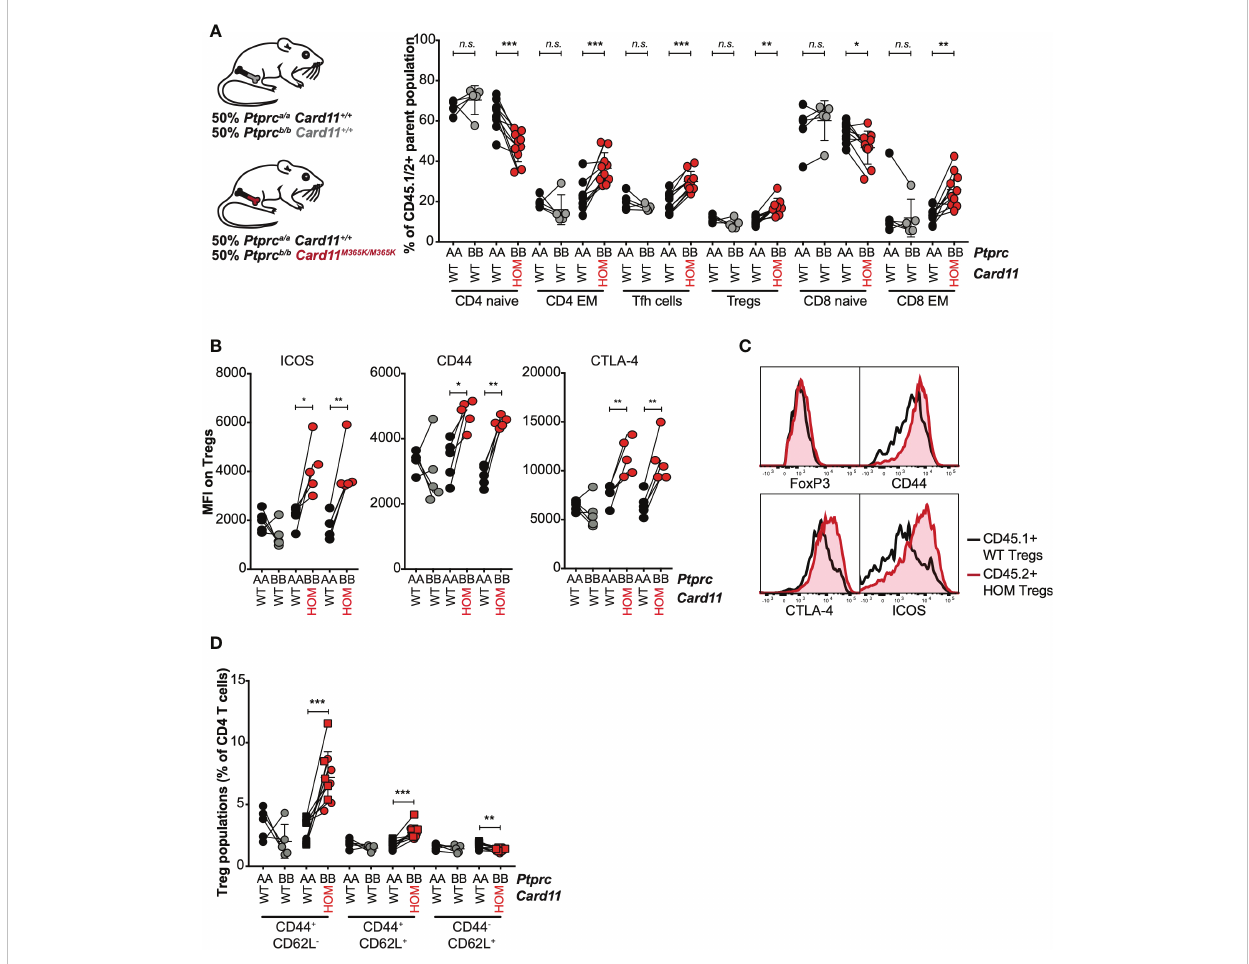
FIGURE 5 GOF Card11 M365K/M365K mutation provides a cell-intrinsic advantage to activated CD8 and CD4 T cells, T follicular helper-like and T regulatory cells. (A-D) . Mixed chimeras were generated by irradiating Rag1 KO/KO Card11 +/+ mice and reconstituting them with Ptprc a/a Card11 +/+ (black fi ll) bone marrow in a 1:1 mixture with Ptprc b/b Card11 +/+ (grey fi ll; 1 donor) or Card11 M365K/M365K (red fi ll; 2 separate donors) bone marrow. These mixed chimeras were sacri fi ced 7 days post-immunization with SRBCs. (A) . Percentage, within the corresponding Ptprc a/a or Ptprc b/b parent population, of CD44 - CD62L + naïve and CD44 + CD62L - effector memory (EM) CD4 T cells, CXCR5 high PD-1 high T follicular helper (T FH ) and CD25 + FoxP3 + T regulatory (T REG ) CD4 T cells, and naïve and EM CD8 T cells. (B) . ICOS, CD44 and CTLA-4 mean fl uorescence intensity (MFI) for Ptprc a/a versus Ptprc b/b